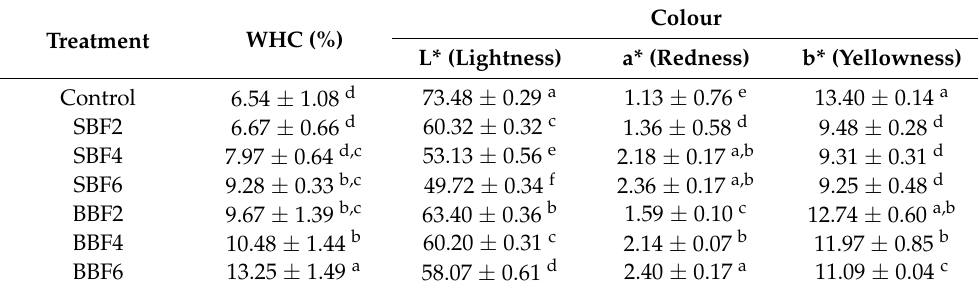
Table 5. Water-holding capacity and colour properties of chicken sausage incorporated with BPF.